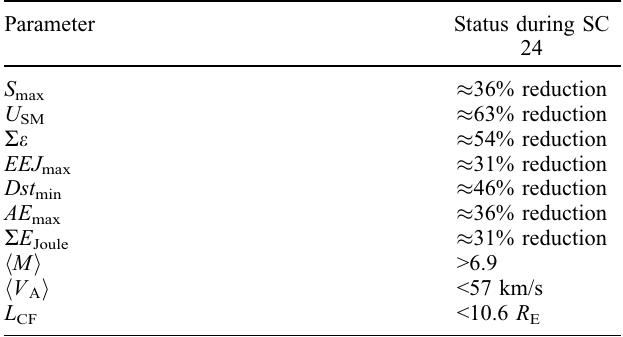
Table 4. Overall changes in different energies and physical parameters encountered during SC 24 as compared to SC 23 at Sun and near Earth environment. The quantities given in second column are mentioned with respect to the SC